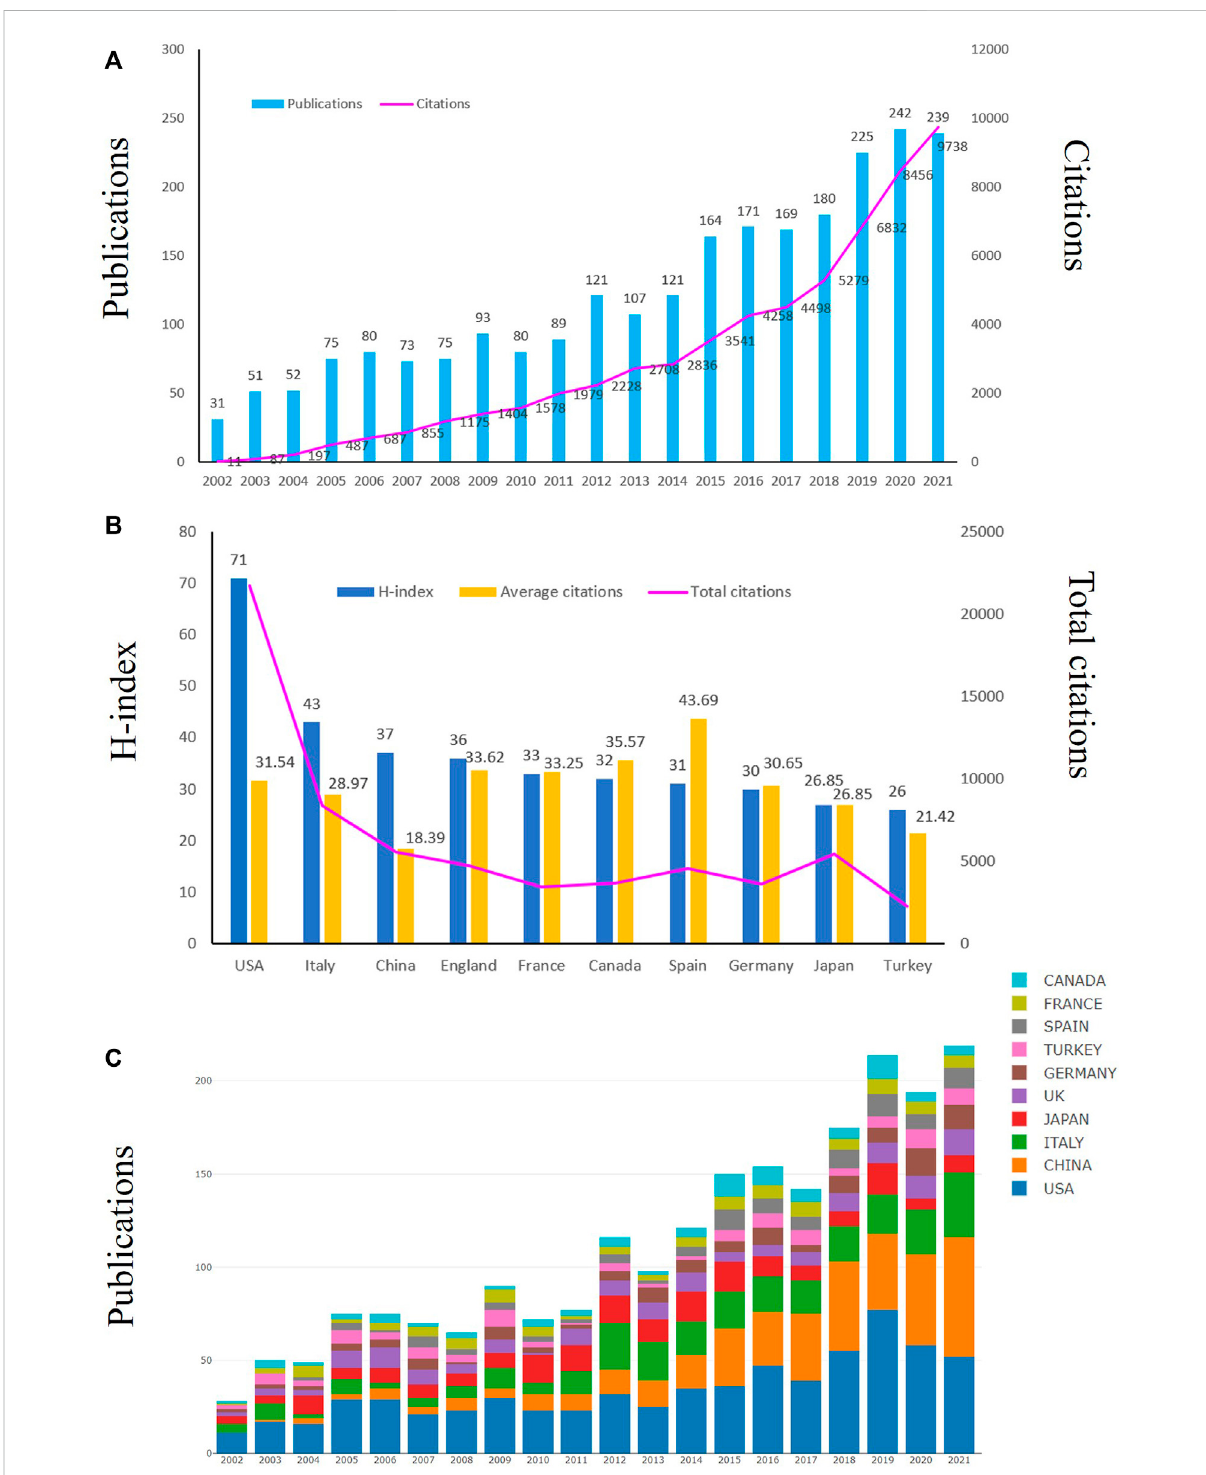
FIGURE 2 Trends in publications and citations of HA for the treatment of OA. (A) The annual trends of global publications and citations. (B) The total citations, average citations (citations per article) and H-index of the top ten countries. (C) The temporal trends of publications from the top ten